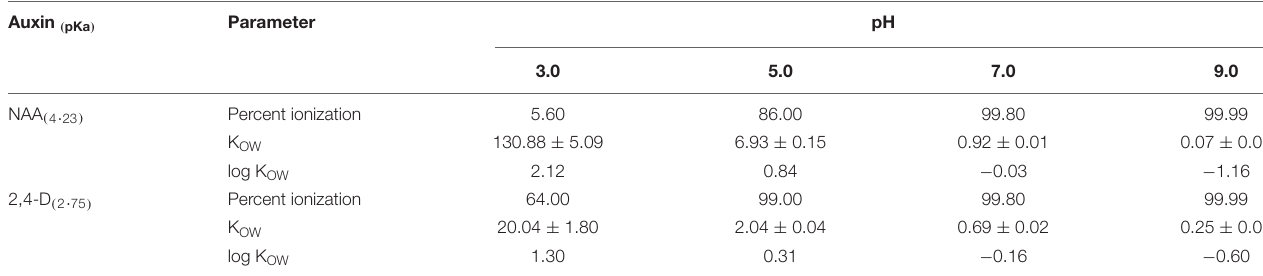
TABLE 1 | Effect of the pH on physicochemical properties of NAA and 2,4-D. Auxin ( pKa